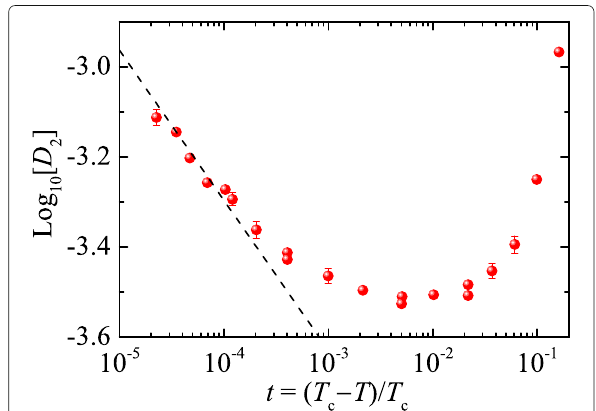
Fig. 2 Second sound diffusivity D 2 , in units of cm 2 /s, as a function of the reduced temperature t = ( T c − T )/ T c . The experimental data (circles) are from Mehrotra and Ahlers in 1983, measured from the resonance line width of cw cavities [40]. The dashed line illustrates the critical behavior D 2 ∝ t − ν/ 2 near the superfluid lambda transition, with a critical exponent ν (cid:3) 2 /